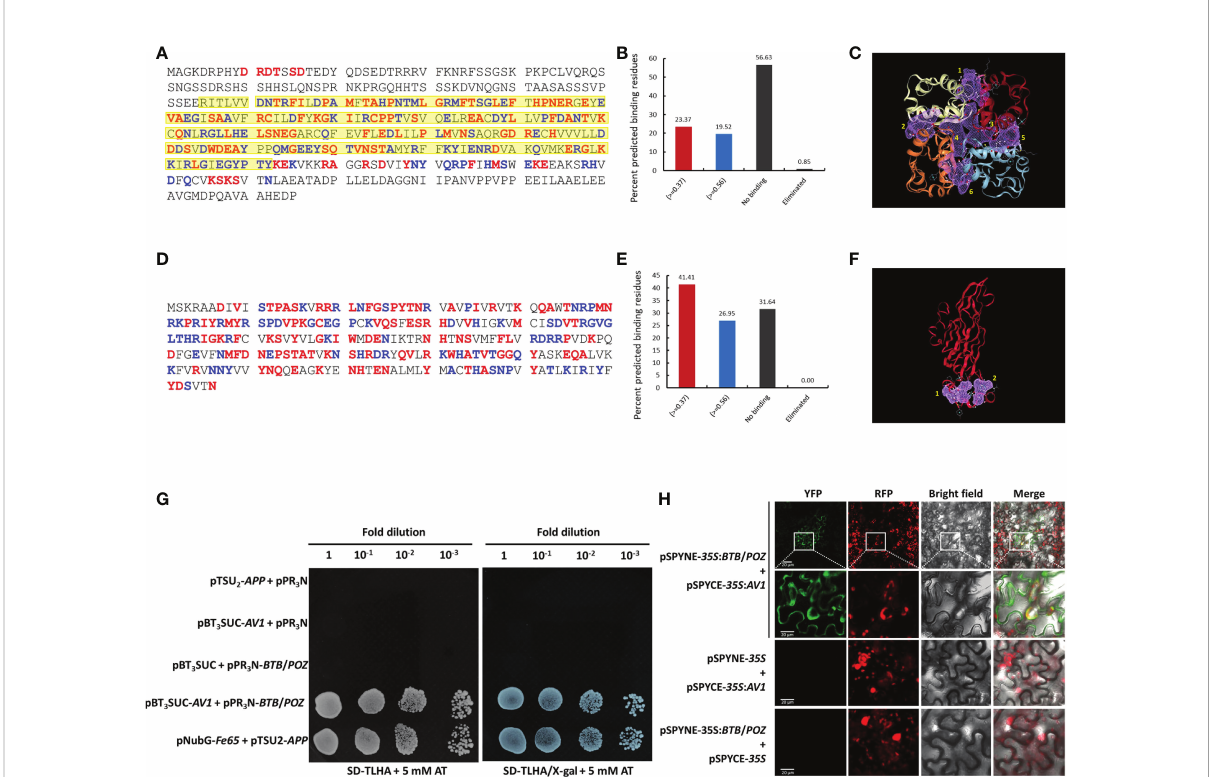
FIGURE 4 In silico prediction and validation of interaction between CLCuMuV-AV1 and white fl y BTB/POZ proteins. (A, B) Prediction of putative binding residues of BTB/POZ protein. Yellow highlighted residues denote area covered by BTB/POZ domain (C) Six putative binding pockets of the BTB/ POZ protein (highlighted in purple-colored grids. (D, E) Prediction of putative binding residues of AV1 protein. (F) Two putative binding pockets of the AV1 protein (highlighted in purple-colored grids. Red color in A, B, D and E panels indicates the predicted binding residues with optimal threshold (>=0.37) while blue color indicates binding residues with more than 90% speci fi city (>=0.56). (G) Yeast two-hybrid (Y2H) assay was performed using bait (pBT 3 SUC- AV1 ) and prey (pPR 3 N- BTB / POZ ) genes. Yeast cells (NMY51) were co-transformed with bait and prey plasmids and grown on synthetic de fi ned media lacking Trp , Leu , His and Ade (SD-TLHA) supplemented with 5 mM 3-amintotrizole with and without X- gal. Serial 10-fold dilutions of yeast cells were made as indicated. Cells co-transformed with pNubG-Fe65 + pTSU 2 -APP served as a positive control, and cells co-transformed with pPR 3 N + pTSU 2 -APP, or with empty vectors (pPR 3 N and pBT 3 SUC) served as negative controls. (H) The interaction between CLCuMuV-AV1 and white fl y BTB/POZ protein was con fi rmed by bimolecular fl uorescence complementation (BiFC) assay. Target proteins were cloned into pSPYCE-35S and pSPYNE-35S vectors to generate C and N-terminus yellow fl uorescence protein (YFP)- tagged expression cassettes. The YFP complementation in the lower epidermal cells of N. benthamiana was observed at 3 dpi using a confocal laser microscope (LSM-710) at 514 nm wavelength. Yellow and red fl uorescence protein signals are represented by YFP and RFP, respectively. Scale bars represent 20